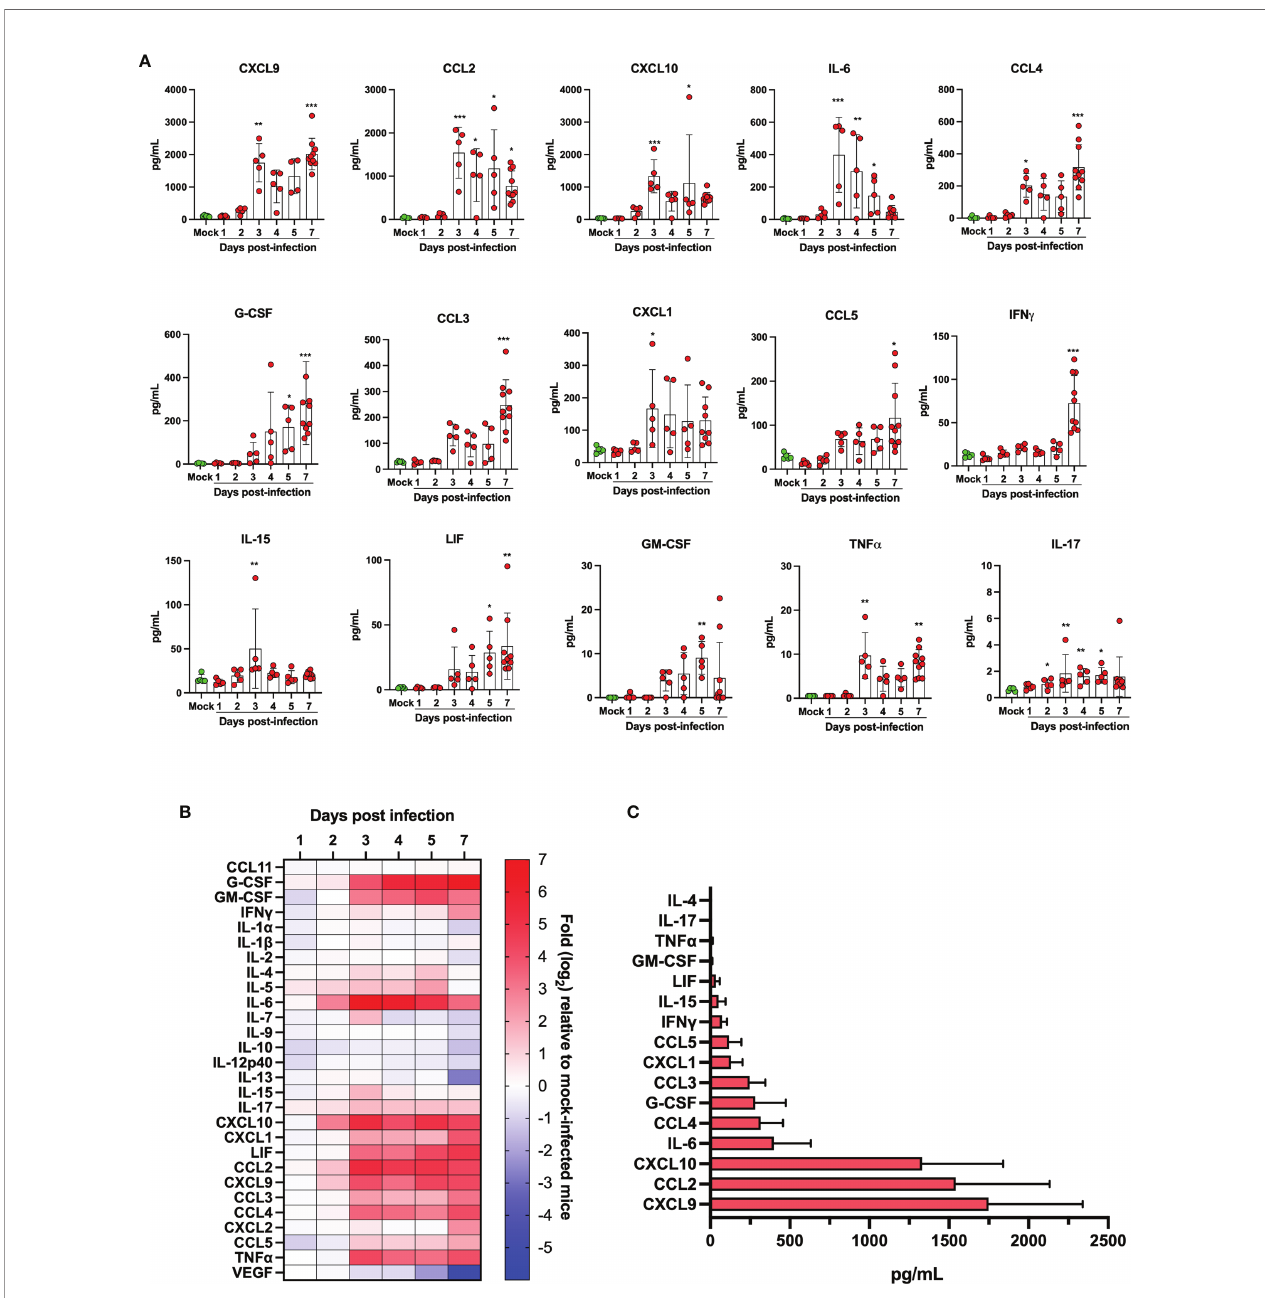
FIGURE 6 | Quanti fi cation of cytokine/chemokines in lung homogenates of mock infected and SARS-CoV-2 infected mice. (A) Bar graphs representing various cytokine/chemokine concentrations in lung homogenates of mock infected or SARS-CoV-2 infected mice at different times post infection. Data are expressed as mean + SD with each dot representing a mouse. (B) Heat map of cytokine/chemokine levels as measured using multiples platform in lungs of mock and SARS-CoV- 2 infected mice at various time points post-infection. Results are expressed as fold expression relative to mock infected mice. (C) Maximal absolute concentration of selected cytokines/chemokines in lungs of SARS-CoV-2 infected mice. Bars represent the mean +SD of the highest cytokine/chemokine concentration detected at any given time during infection. *p<0.01, **p<0.01,